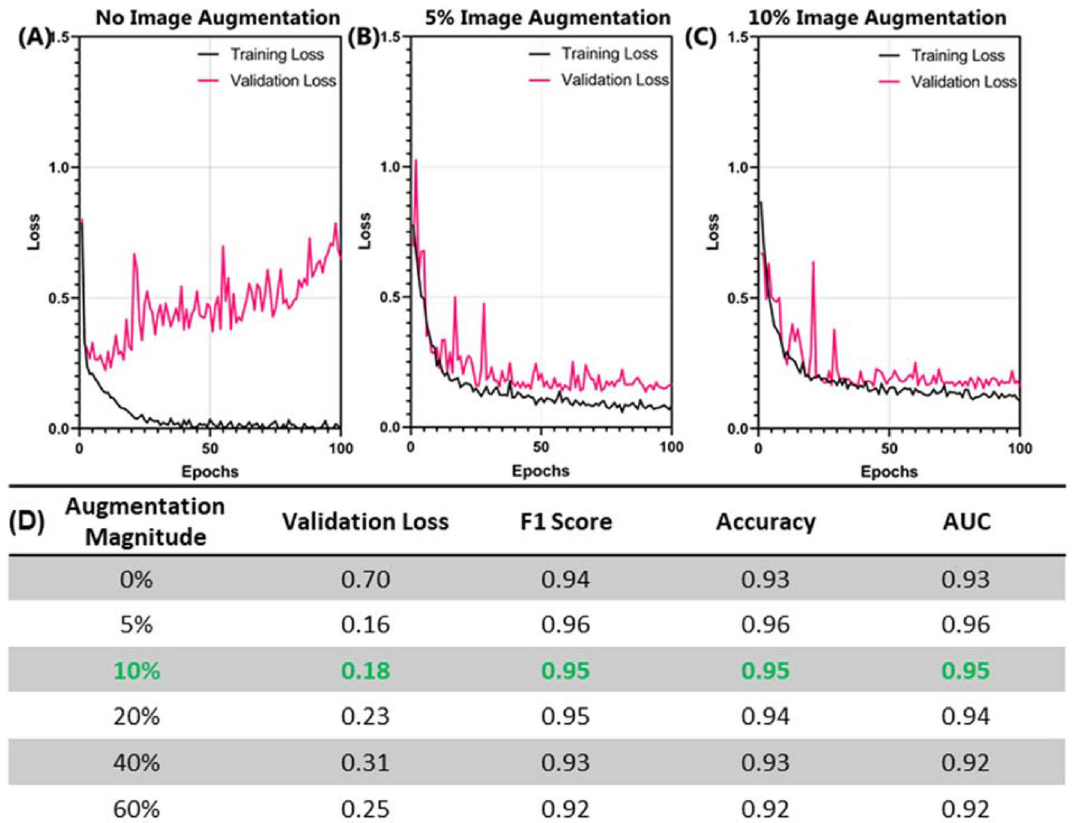
Figure 2. Effect of image augmentation on model performance. ( A–C ) Training and Validation loss plots for models with ( A ) no image augmentation, ( B ) 5% image augmentation and ( C ) 10% image augmentation for the 100 epochs. ( D ) Summary of performance statistics for the different magnitudes of the image augmentation. Performance is shown for average validation loss for the last 5 epochs and F1 score from the test phantom images. Green text font represents the selected model architecture for subsequent optimization